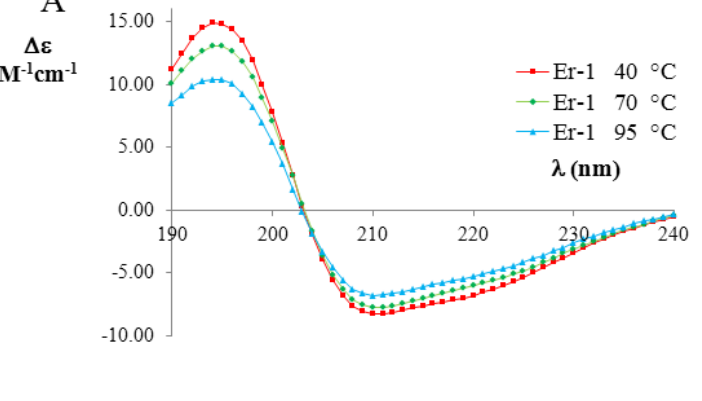
Figure 3. Far-UV circular dichroism (CD) spectra (expressed in Δε units) of the mesophilic, E r -1 ( A ), and psychrophilic, E n -1 ( B ), pheromones (20 mM, pH 6) at three selected temperatures (red 40 ° C; green 70 °C; and blue 90 °C). The raw CD data were kindly supplied by M. Geralt and reported in